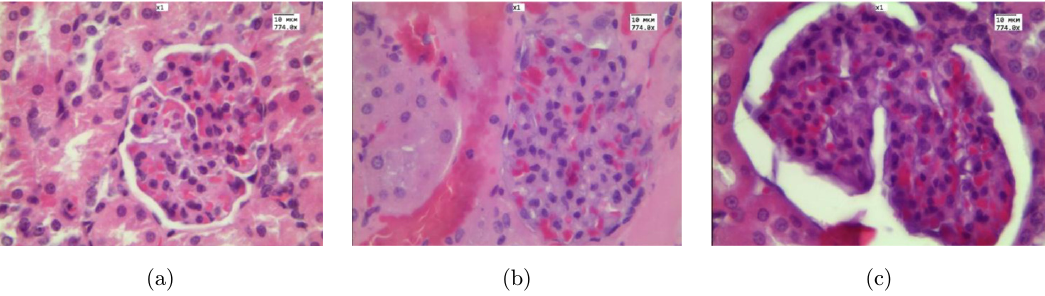
Fig. 3. Histological sections of kidney: (a) Comparison group (rat with PC-1). The moderate congestion in the glomeruli. (b) Group with laser hyperthermia. The moderate congestion in the glomeruli, foci of hemorrhage between the tubules. (c) Group with PPTT. The swelling between the capsule of glomerulus. Staining with hematoxylin and eosin. ( (cid:3) 774).